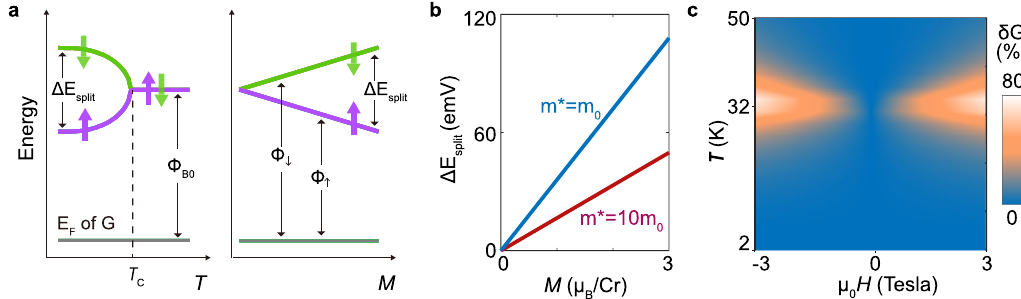
Fig. 4 Relation between spin splitting energy and magnetization. a Schematic diagram of the relevant energies involved in the electron tunneling process. The spin-up and spin-down CrBr 3 conduction bands become nondegenerate when the magnetization M is fi nite, causing a different height of the tunneling barrier for electrons whose spin points in opposite directions (the barrier height is given by the distance between the corresponding band edge and the Fermi level E F in the graphene electrodes, indicated by the bottom horizontal line). A fi nite M can be induced by the appearance of the spontaneous magnetization as T is lowered below T C , or by the application of an external magnetic fi eld for T > T C . b Magnetization dependence of the splitting energy, as determined from fi tting of the data in Fig. 3 c using the spin-dependent Fowler – Nordheim tunneling model to model the conductance. The blue and purple lines correspond to the results obtained assuming the effective mass in the direction perpendicular to the layers of CrBr 3 to be m 0 or 10 m 0 , respectively. c Color map of magnetoconductance calculated using Eq. (2) in the main text, using the Weiss model to determine the dependence M ( H , T ) of the magnetization on magnetic fi eld